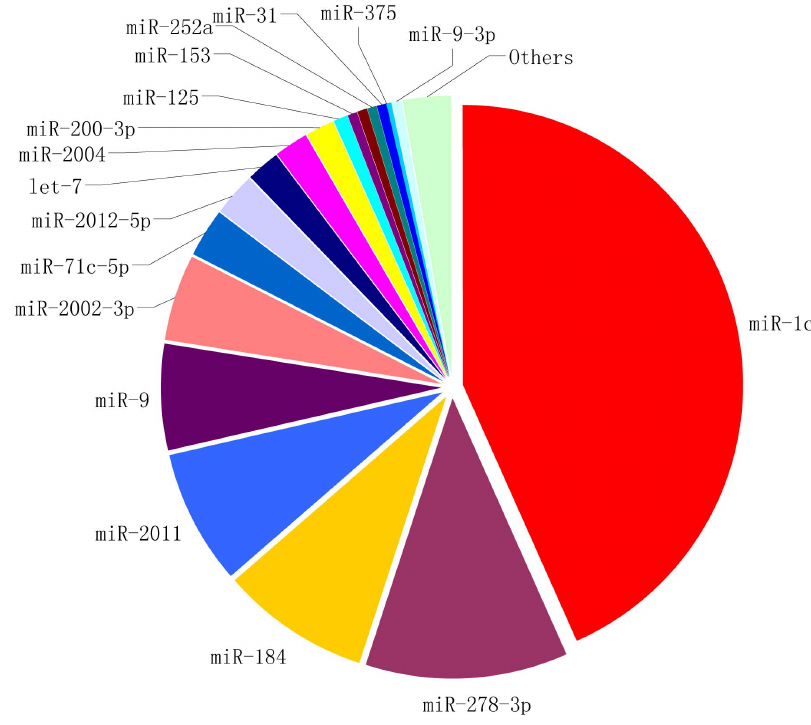
Figure 2. Relative abundance of conserved miRNAs identified from the tube foot of sea cucumber ( A.japonicus ). doi:10.1371/journal.pone.0111820.g002 PLOS ONE |